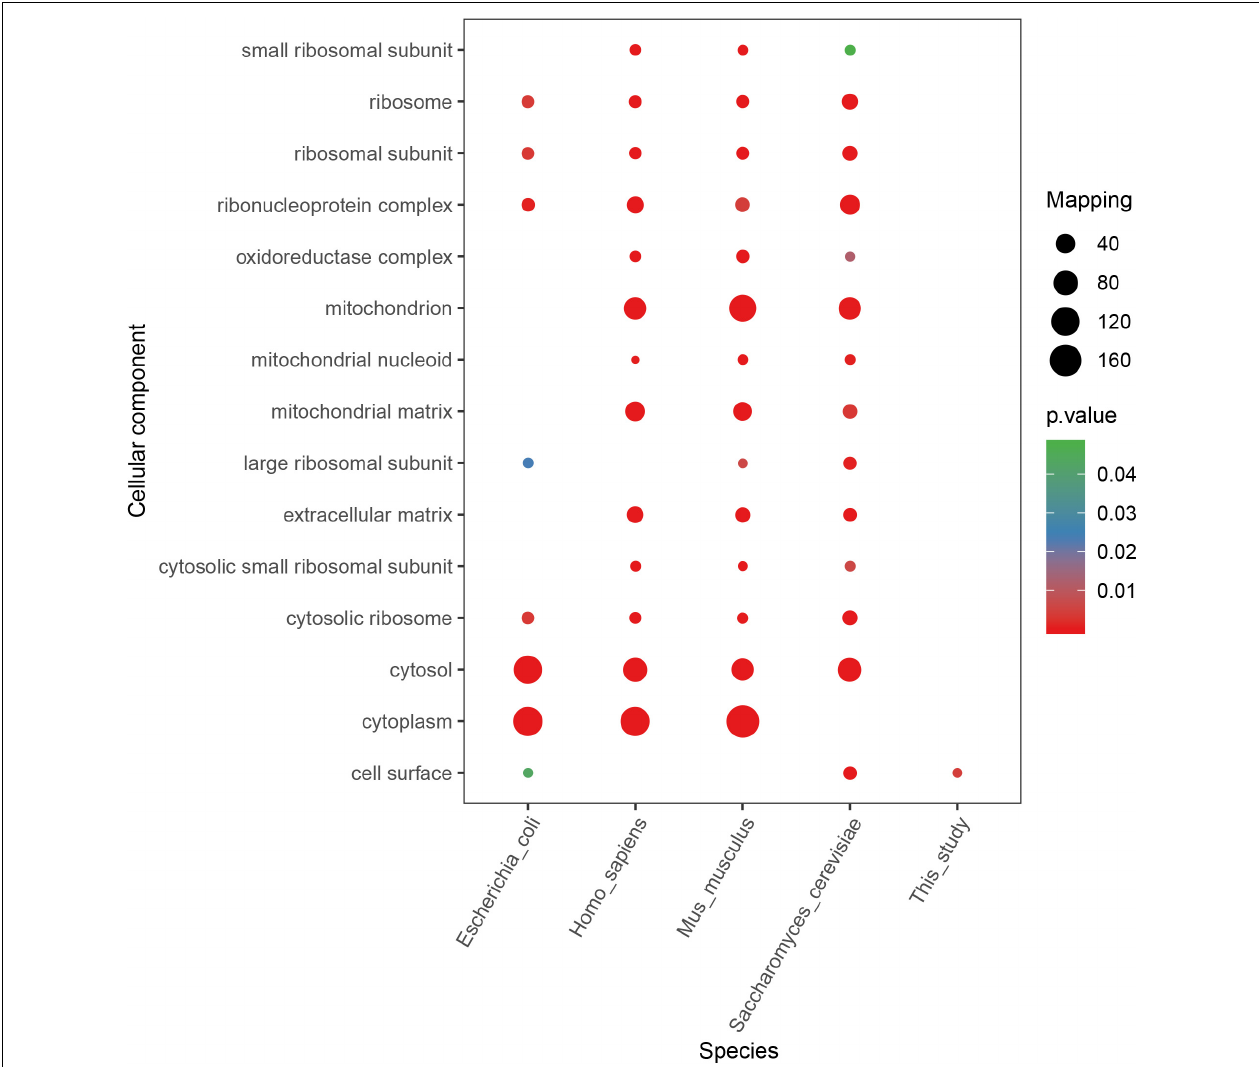
FIGURE 8 | Cellular component enrichment analysis of succinylated proteins with KsuD motif among five organisms ( Escherichia coli , Homo sapiens , Mus musculus , Saccharomyces cerevisiae , and Staphylococcus epidermidis ).